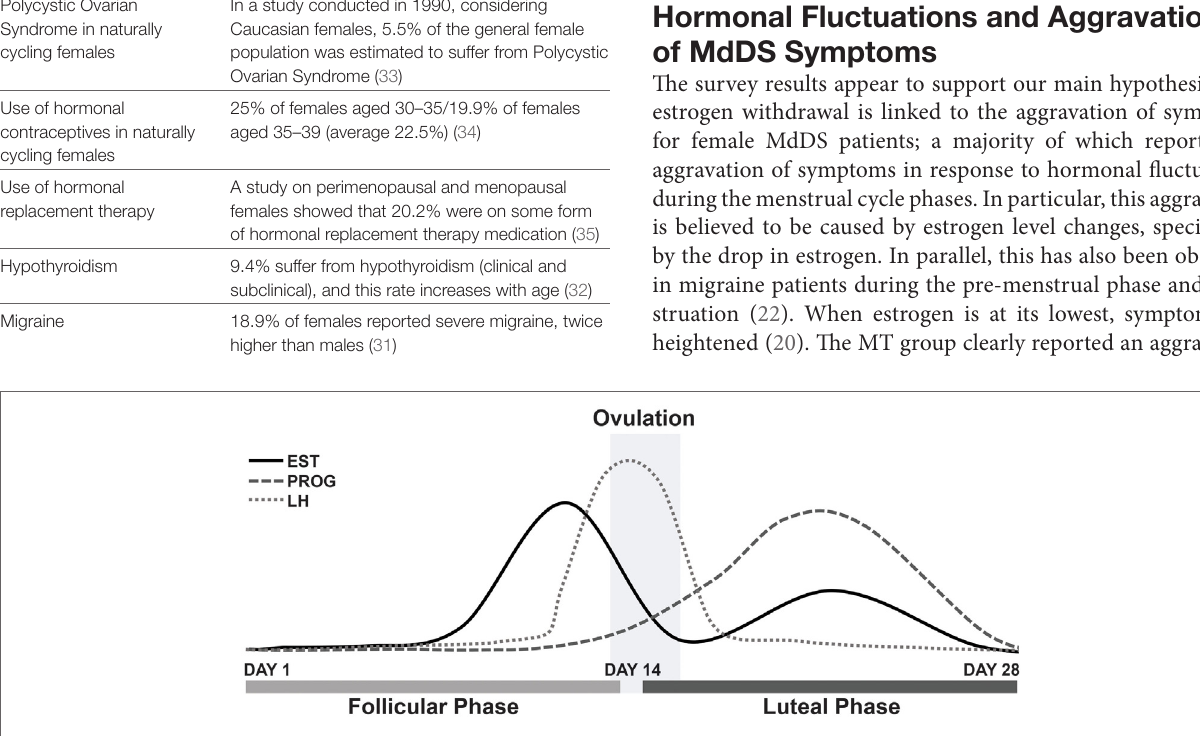
FigUre 2 | Fluctuations of estrogen, progesterone and luteinizing hormone during a typical 28-day menstrual cycle. Abbreviations: EST, estrogen; PROG, progesterone; LH, luteinizing hormone